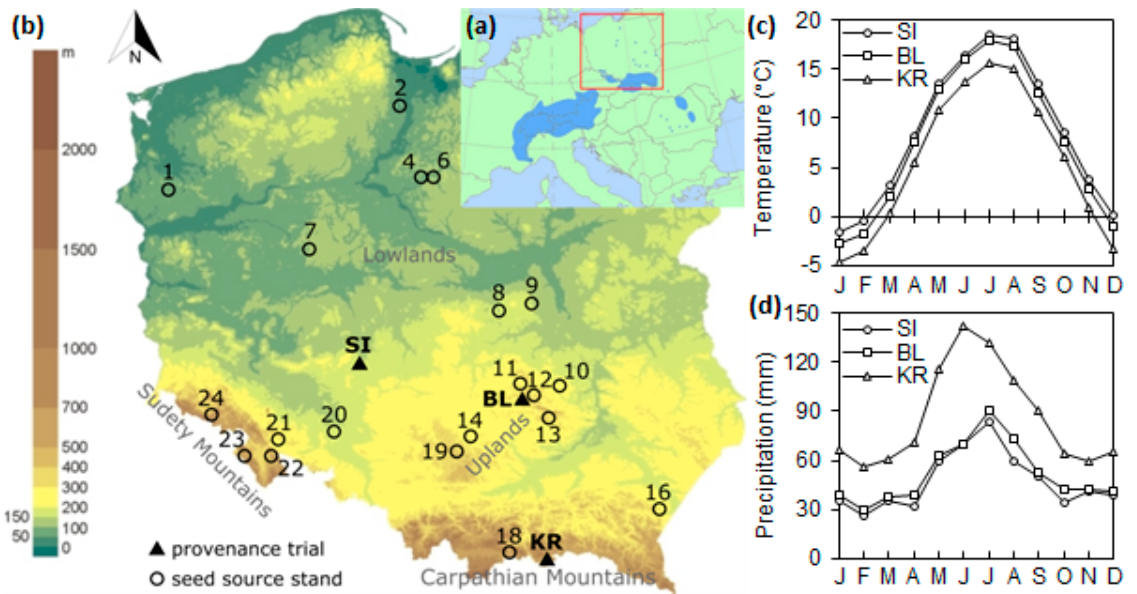
Figure 1. Natural distribution range of European larch ( a ) [35]. Locations of the provenance trials in Siemianice (SI), Bli˙zyn (BL) and Krynica (KR), and locations of the seed source stands ( b ) (dots with provenance numbers; their names are in Table 2; source of map layer: [36]). The climate diagrams for the provenance trials show the mean monthly air temperature ( c ) and total monthly precipitation ( d ) for the period 1970–2015. Table 1. Summary information on the main characteristics of the larch provenance trials [1,4,34].